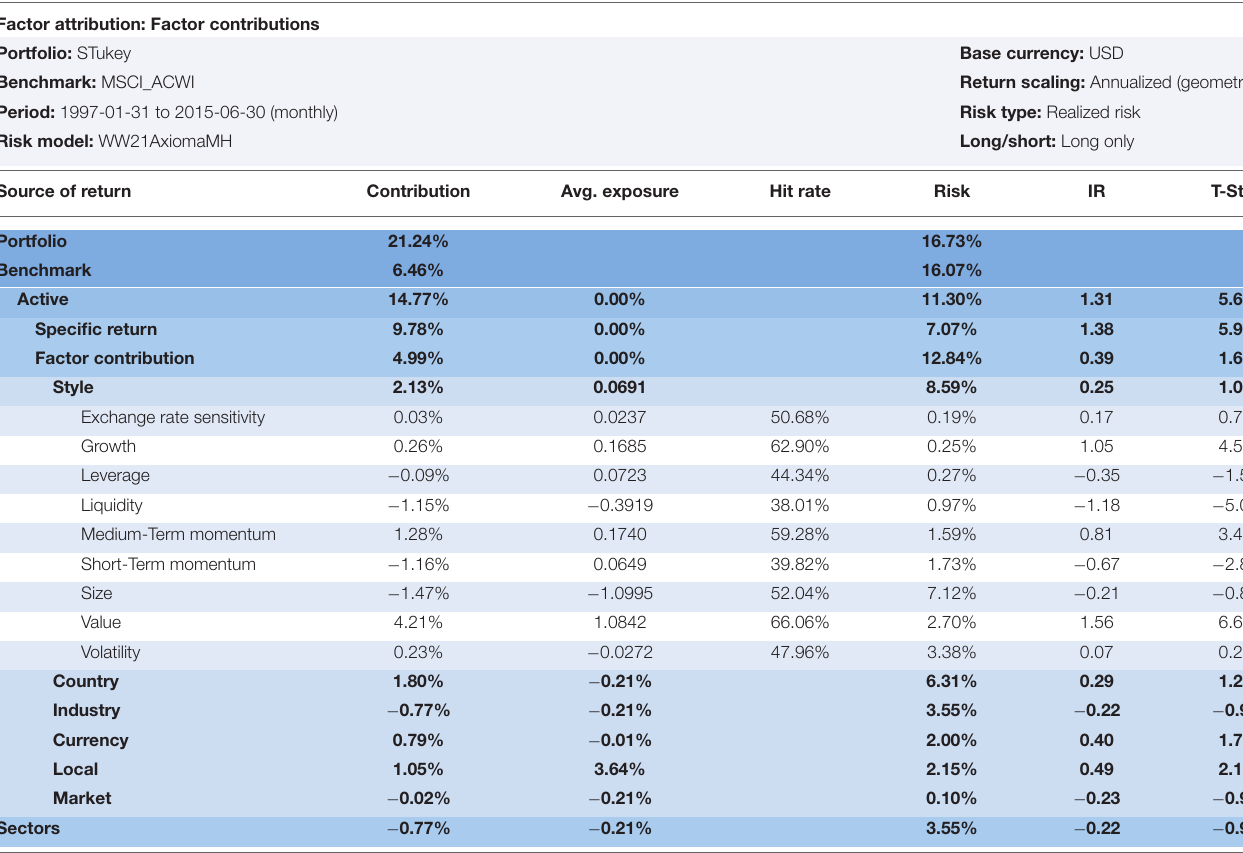
TABLE 7 | Robust regression with the S-procedure of